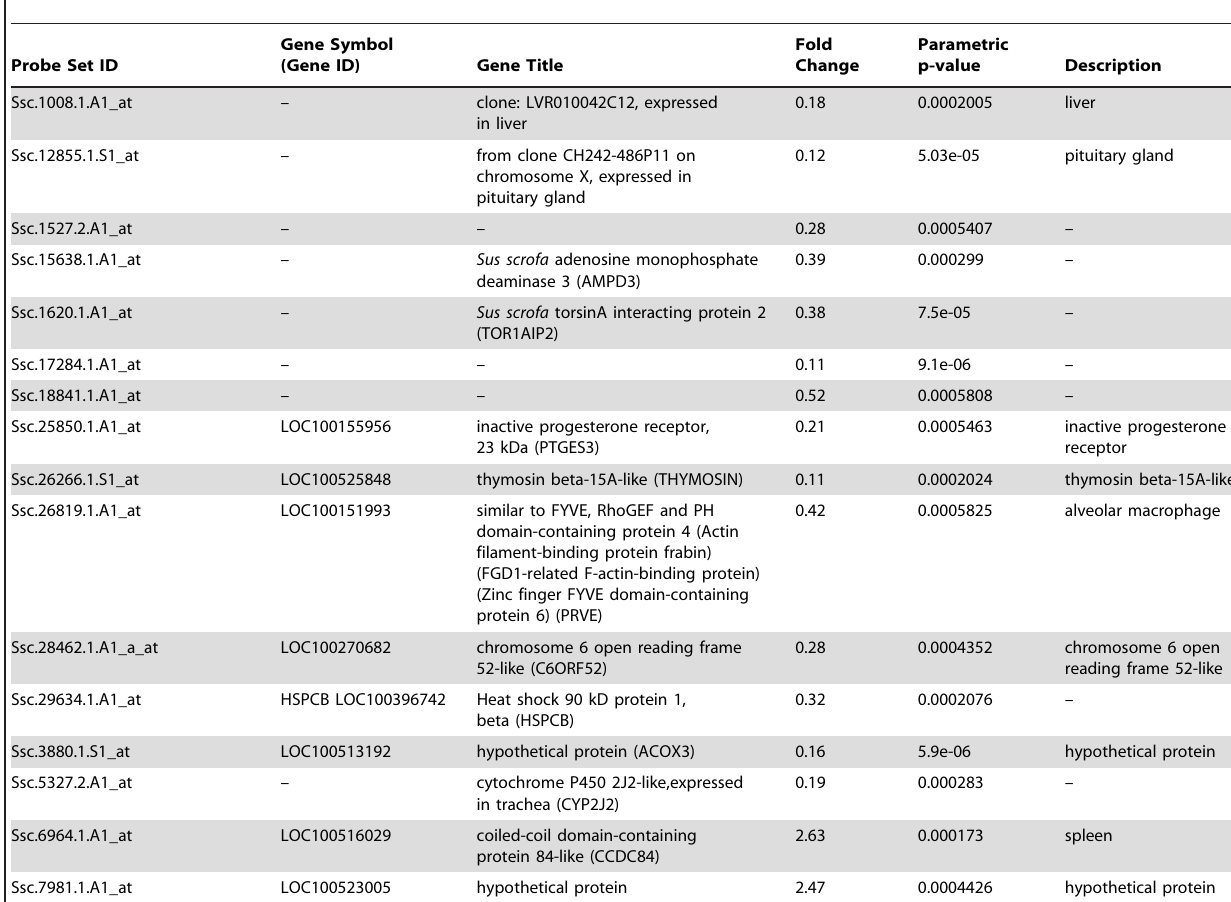
Table 2. Differentially expressed genes between PRRSV-infected DPL and DLY pigs.